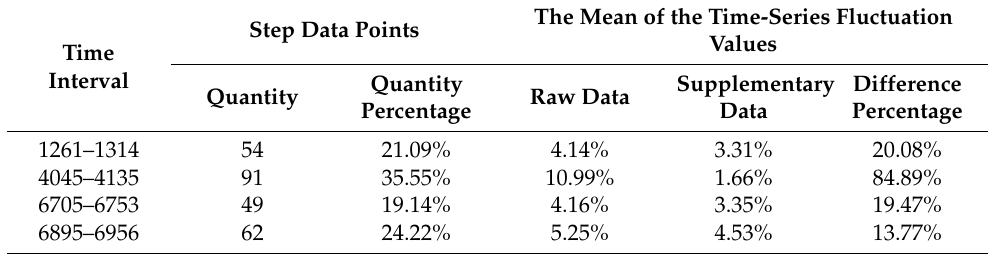
Table 4. Step data points and associated calculation results for the flow of return water.